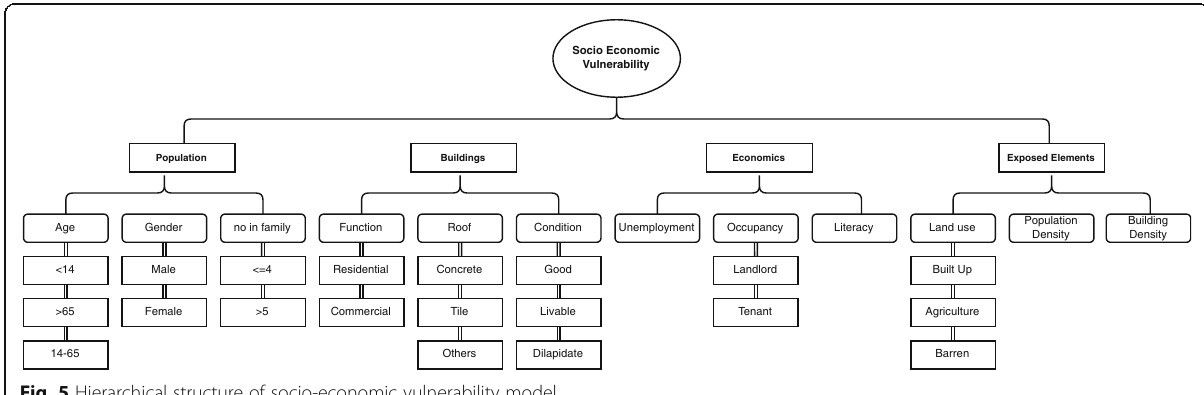
Fig. 5 Hierarchical structure of socio-economic vulnerability